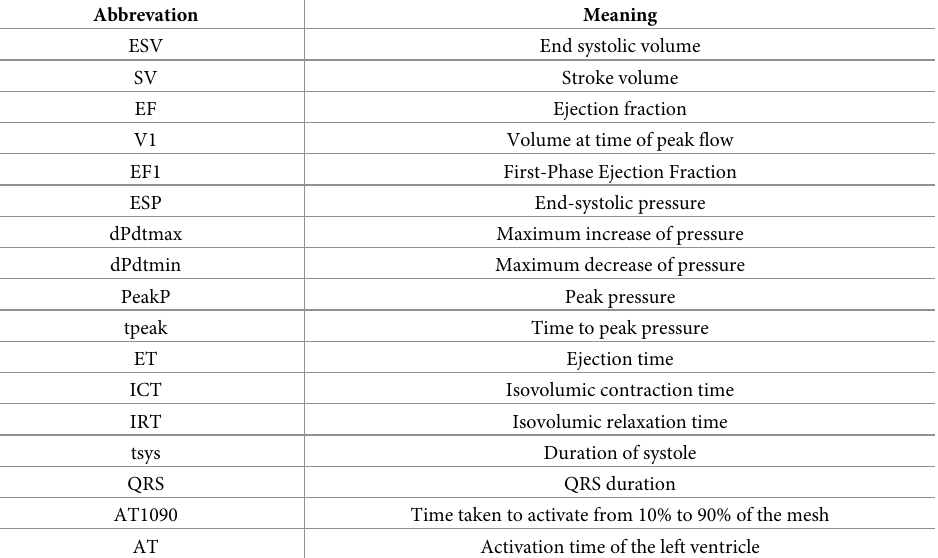
Table 1. Measurements taken from the meshes and the EM simulations, with the acronyms used in the text and plots. The first group corresponds to volume-based metrics, the second to pressure-based, third to time/duration- based and the bottom group to EP-based